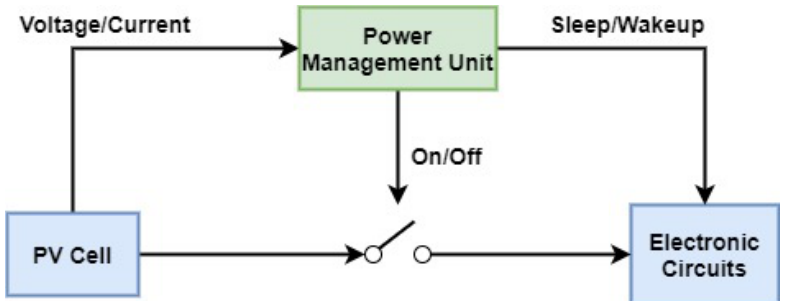
Figure 4. A conventional architecture of energy harvesting devices with the direct utilization of energy to power Internet of Things (IoT)